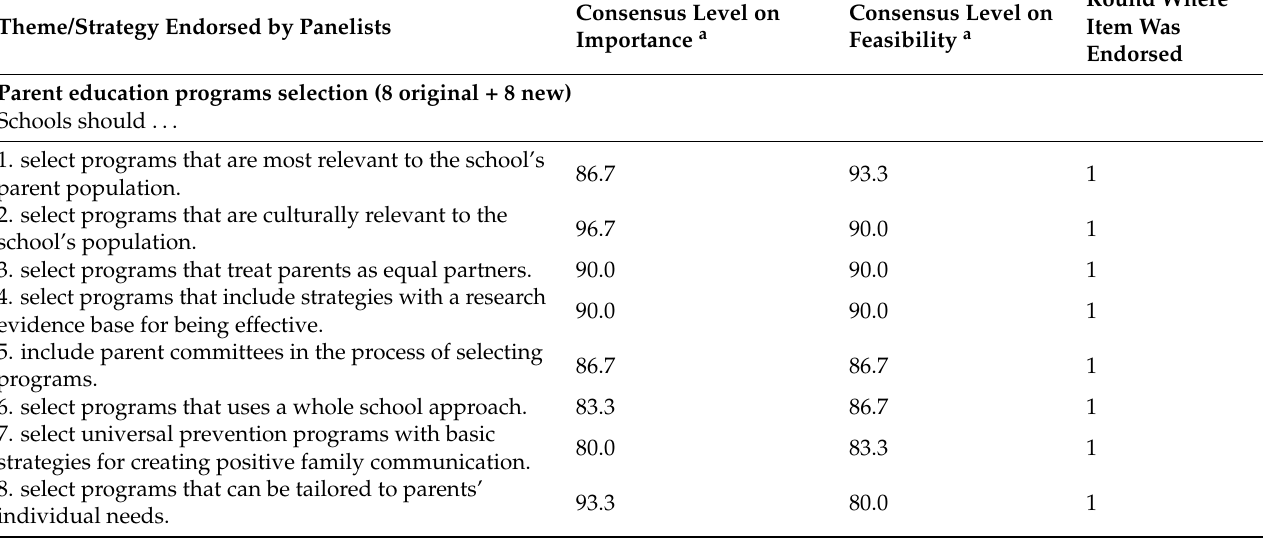
Table 1. List of original and new strategies endorsed by panel across three survey